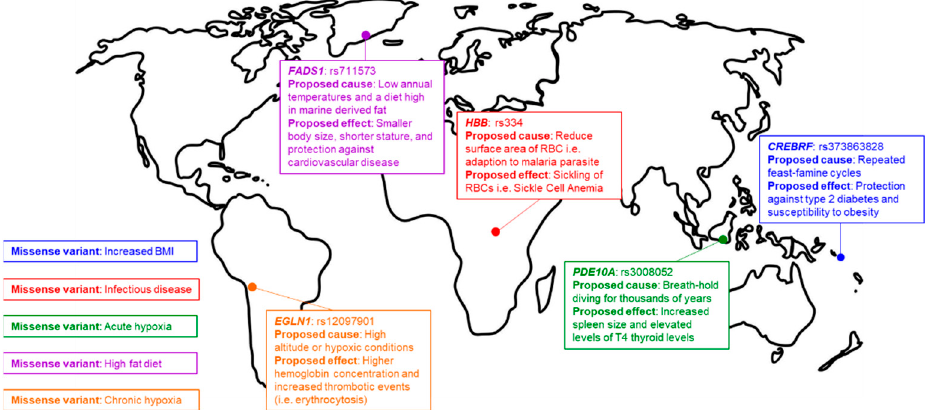
Figure 1. Signatures of natural selection. Examples of human local adaptations, each labeled by the phenotype and/or selection pressure, and the genetic loci under selection. phenotype and / or selection pressure, and the genetic loci under